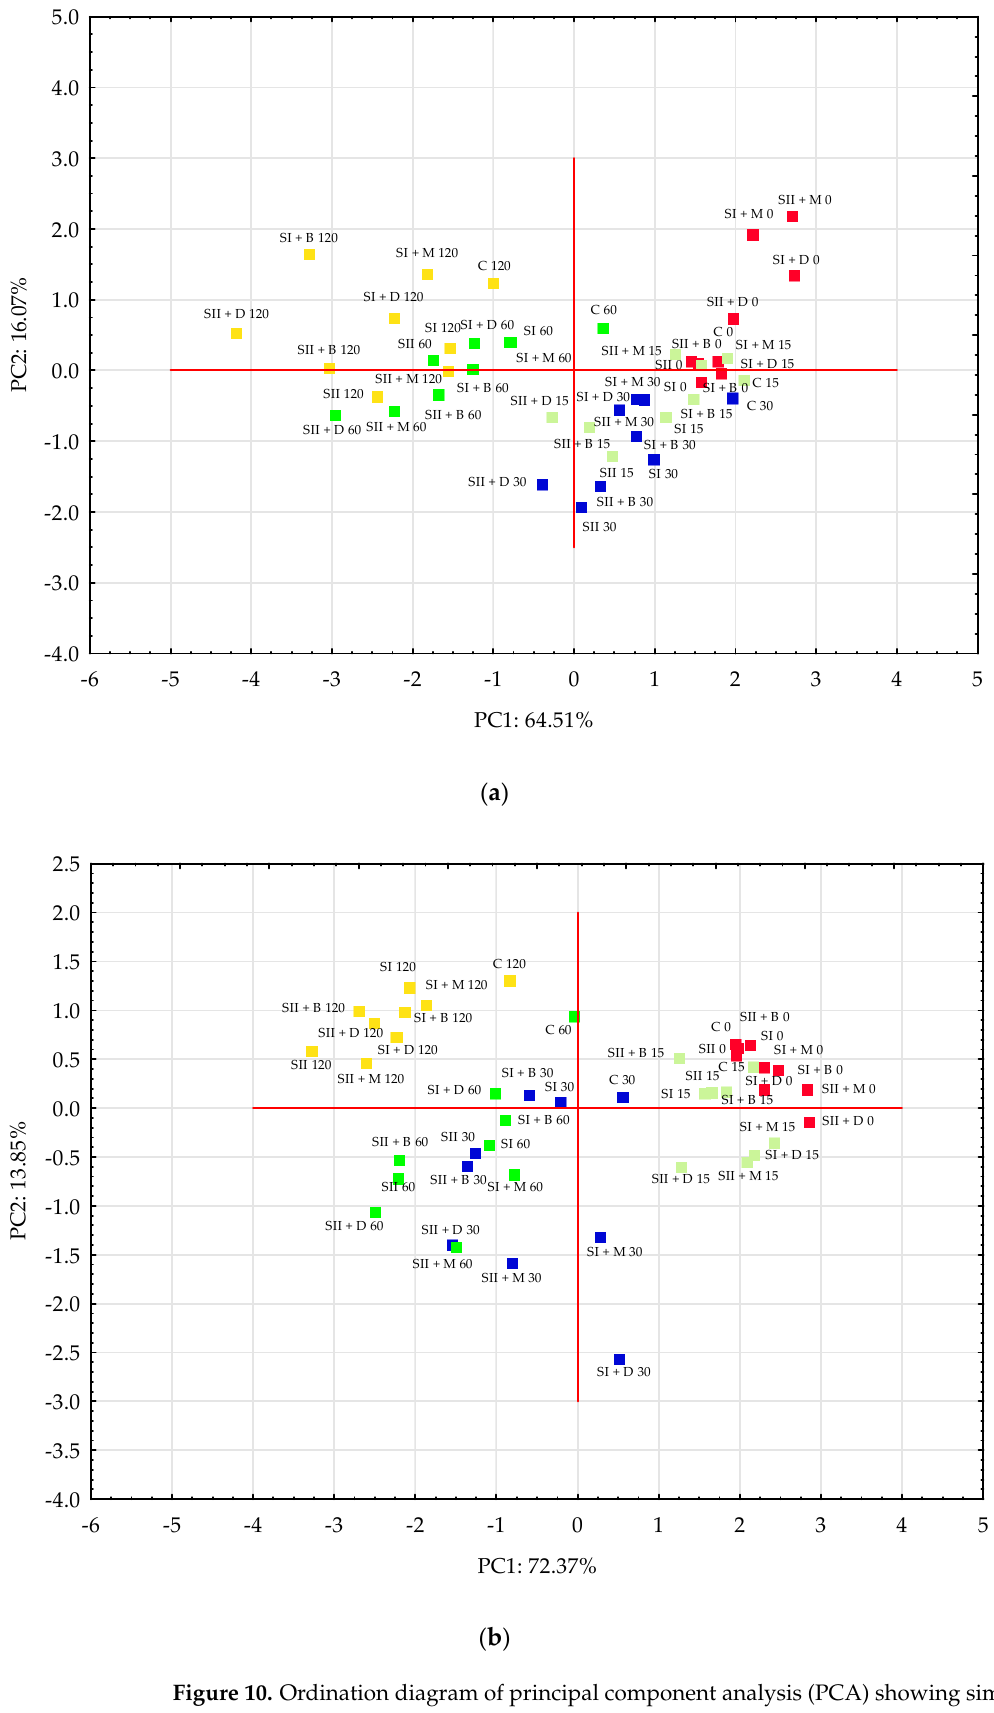
Figure 10. Ordination diagram of principal component analysis (PCA) showing similarities